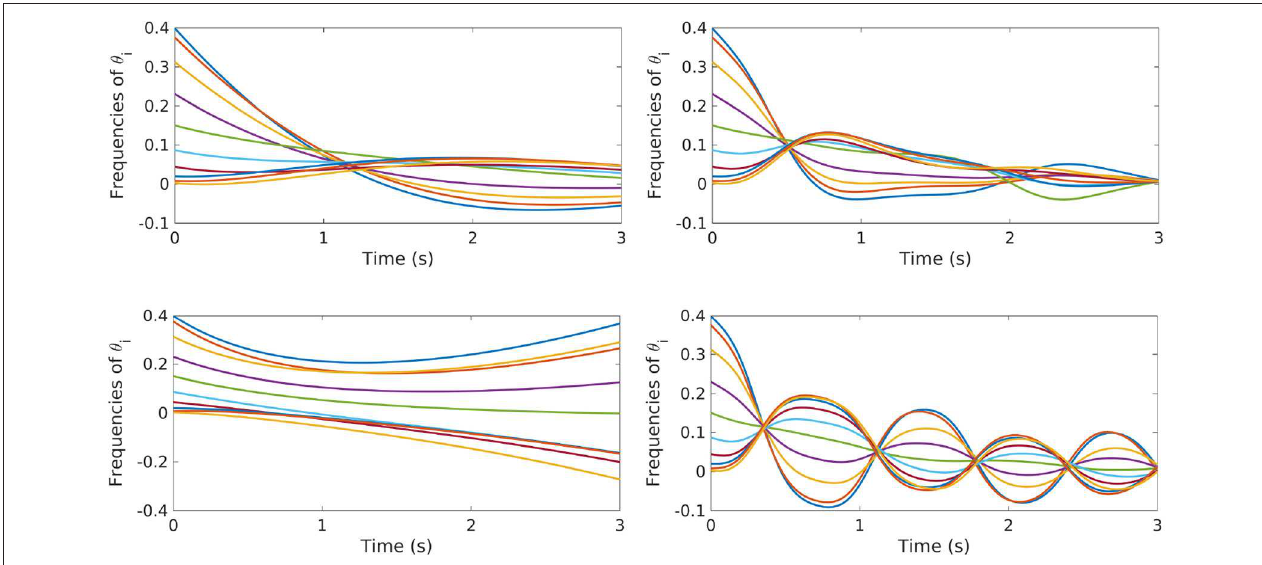
10 oscillators and K > K * (top) and =